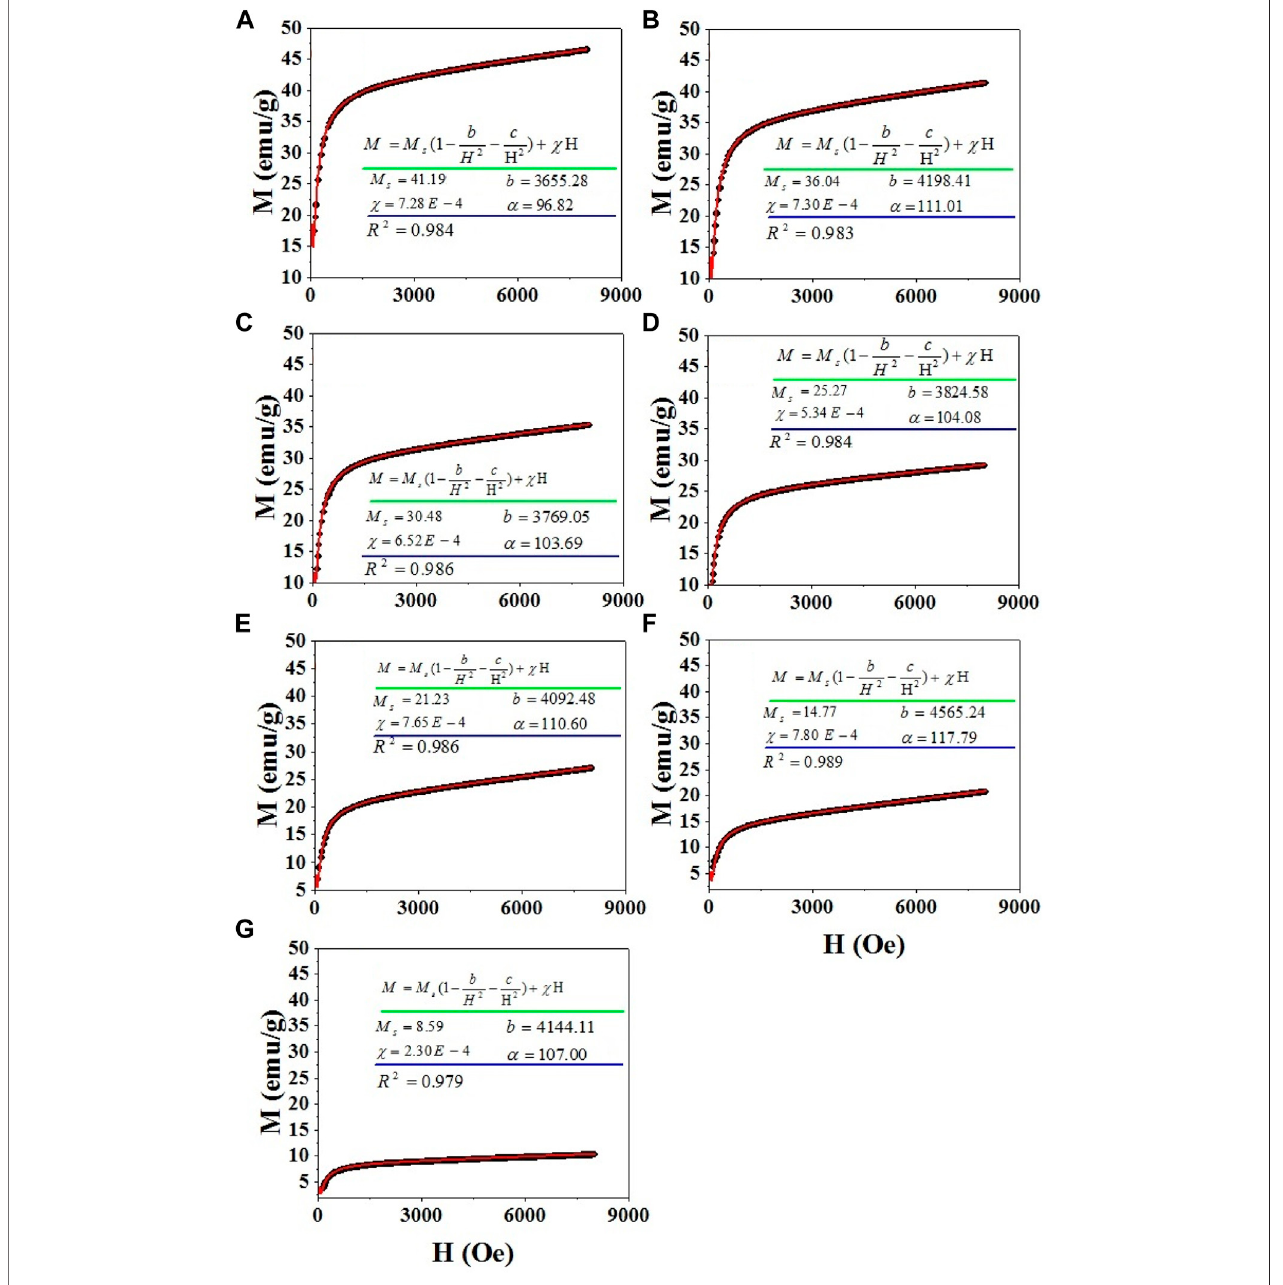
FIGURE8| LAS fi ttingofmagnetizationcurvesofCd x Mg 0.30- x Cu 0.20 Zn 0.50 Fe 2 O 4 nanoparticles forsamples (A) x (cid:1) 0.00, (B) x (cid:1) 0.05, (C) x (cid:1) 0.10, (D) x (cid:1) 0.15, (E) x (cid:1) 0.20, (F) x (cid:1) 0.25, (G) x (cid:1)